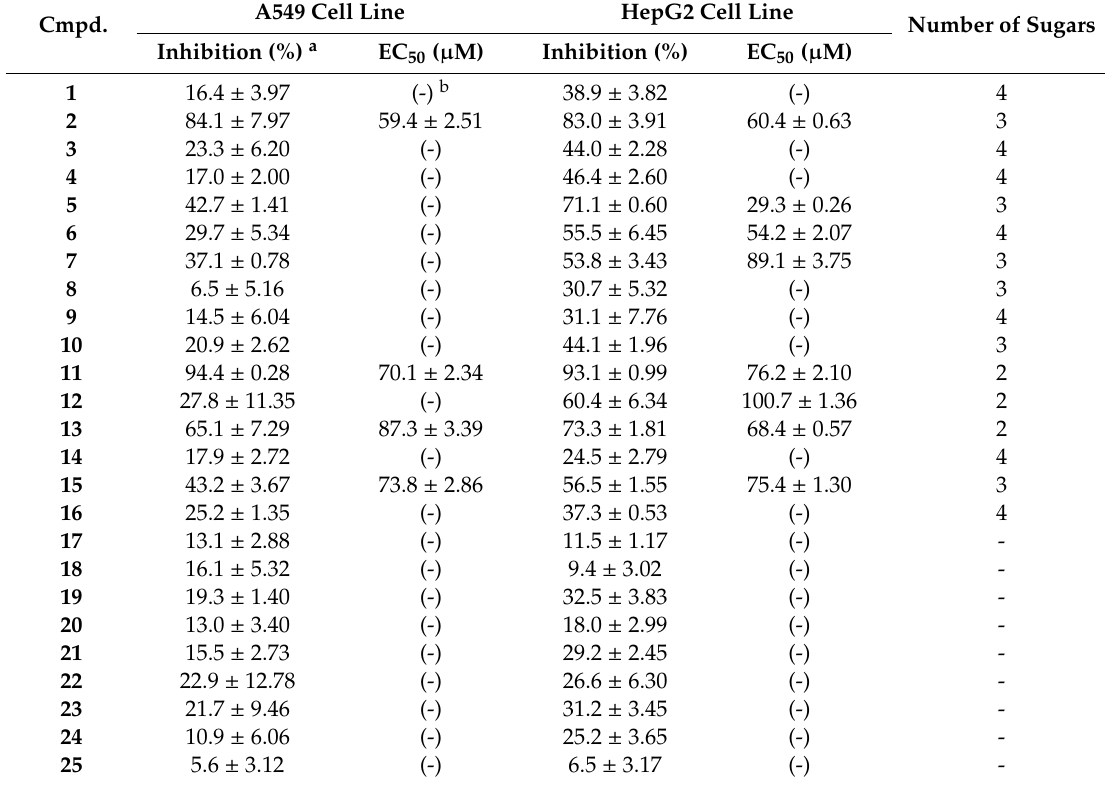
Table 3. Antiproliferative data for compounds 1 – 25 against cancer cell lines.